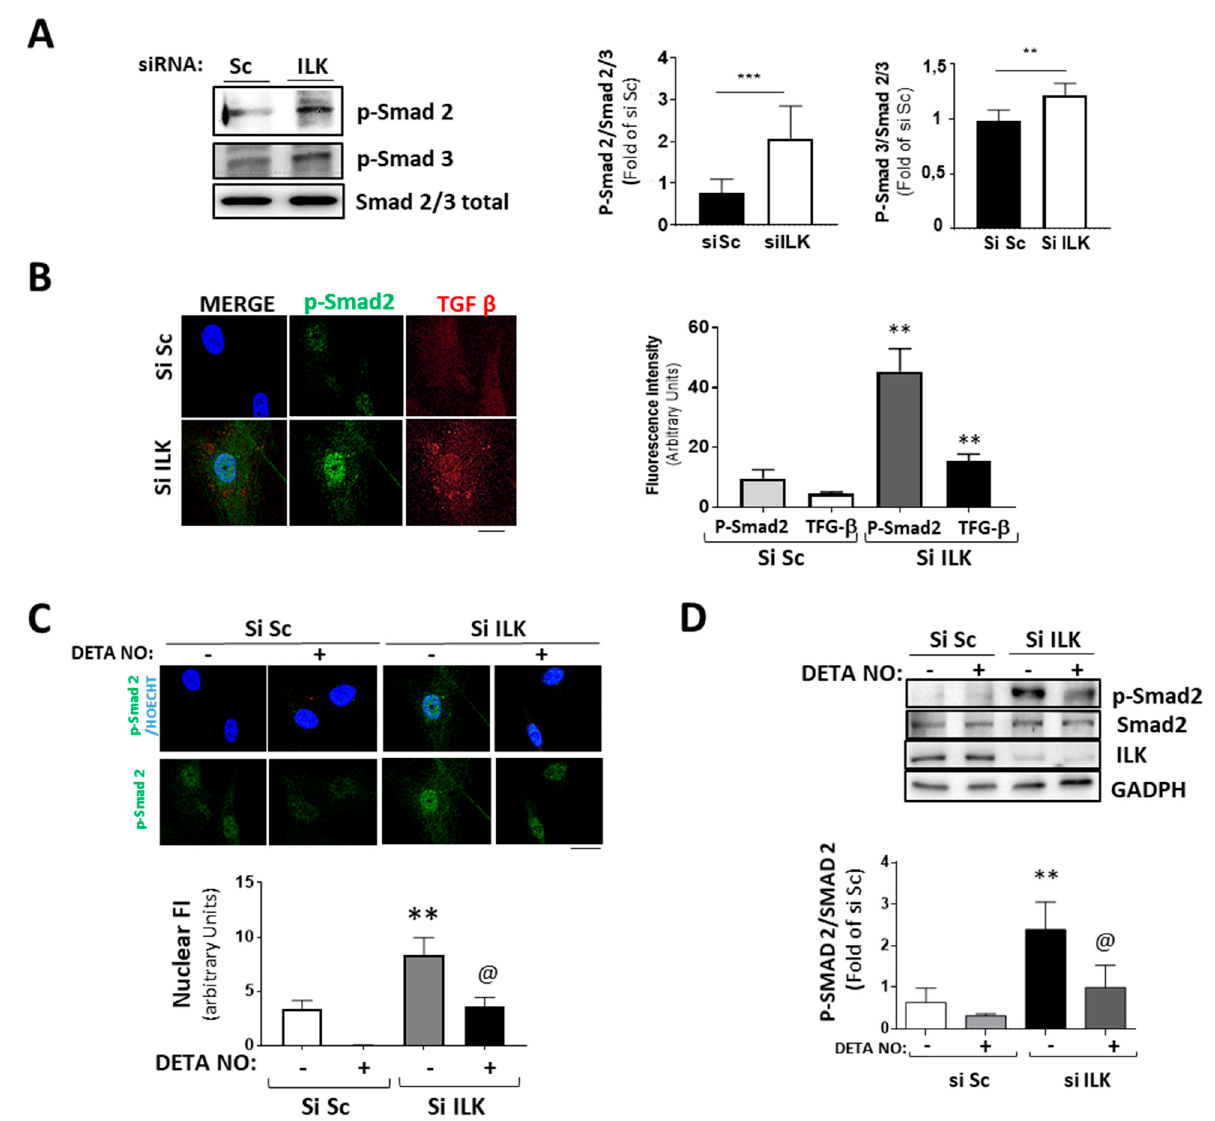
Figure 5. Silencing of ILK in hVECs induced EnMT through the TGF/SMAD2/3 axis in a nitric-oxide- dependent manner. ( A,B ) hVECs transfected with siSc or siILK for 5 days. ( A ) Western blot analysis and quantification of phospho-Smad2 and phospho-Smad3. *** p < 0.0001 vs. Si Sc; ** p < 0.001 vs. Si Sc ( B ) Immunofluorescence of phospho ‐ Smad2 (green) and TGF ‐β (red) and quantification of fluo ‐ rescence intensity (right). n = 6. ** p < 0.001 vs. Si Sc. ( C , D ) hVECs transfected with siSc or siILK and treated with DETA ‐ NONOate for 5 days. Quantification of nuclear translocation (right). n = 6. ** p < 0,001 vs. Si Sc. ( C ) Confocal fluorescent microscopy images of phospho ‐ Smad2. ( D ) Western blot analysis of phospho ‐ Smad2 and quantification. n = 6. ** p < 0.001 vs. Si Sc; @ p < 0.001 vs. Si ILK.